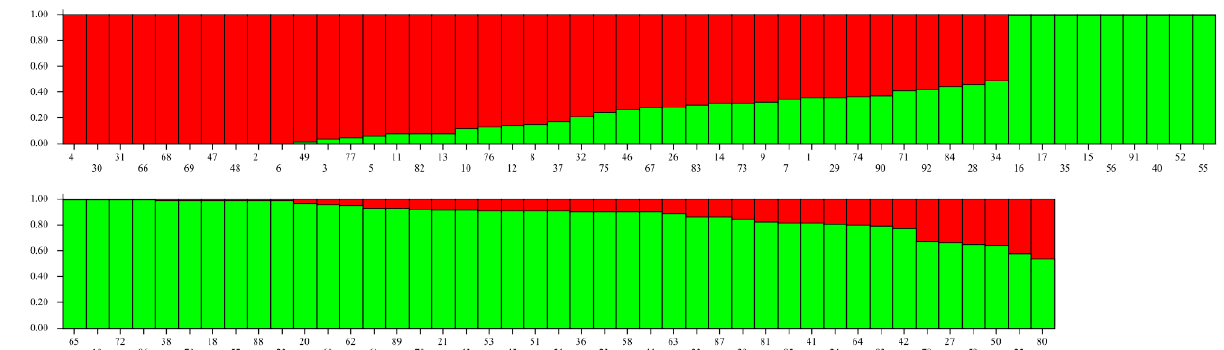
Figure 3. STRUCTURE bar plot for K = 2 using a model based on admixture with correlated allele frequencies. Fox identities are represented by vertical bars. Distinct colours of the bars (red and green) represent the proportion of admixture (Q), or ancestry. Fox ID’s are present on the X -axis and are ordered according to the Q values presented on the Y -axis. N.B., the X -axis is continuous.